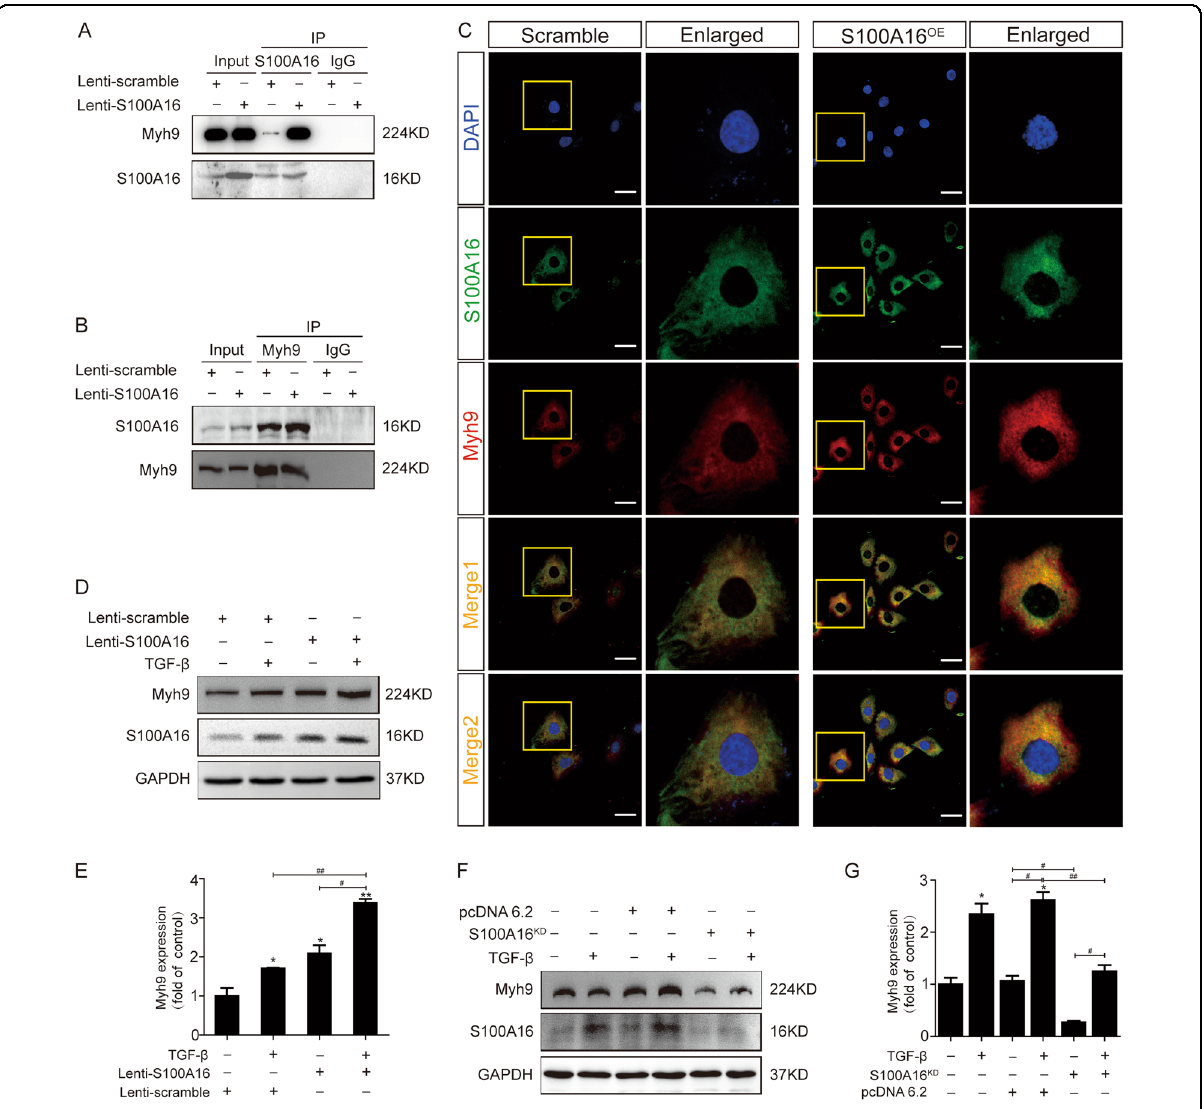
Fig. 5 Myh9 physically interacts with S100A16. a , b An interaction between Myh9 and S100A16 was detected in the co-immunoprecipitation analysis in normal and lenti-S100A16 virus-treated HK-2 cells. The binding between S100A16 and Myh9 was con fi rmed in immunoprecipitation assays performed using anti-Myh9 antibodies and blotted with anti-S100A16 antibodies in lenti-scrambled and lenti-S100A16 virus treated HK-2 cells. c S100A16 and Myh9 partially colocalized in normal and S100A16 overexpressing HK-2 cells. Scale bar = 20 μ m. d – g HK-2 cells transfected with lenti- scrambled, lenti-S100A16 virus, and S100A16 knockdown plasmids were stimulated with TGF- β (20 ng/ml). Representative bands of western blots are shown for the expression of Myh9. * p < 0.05, ** p < 0.01 vs. control; # p < 0.05, ## p <